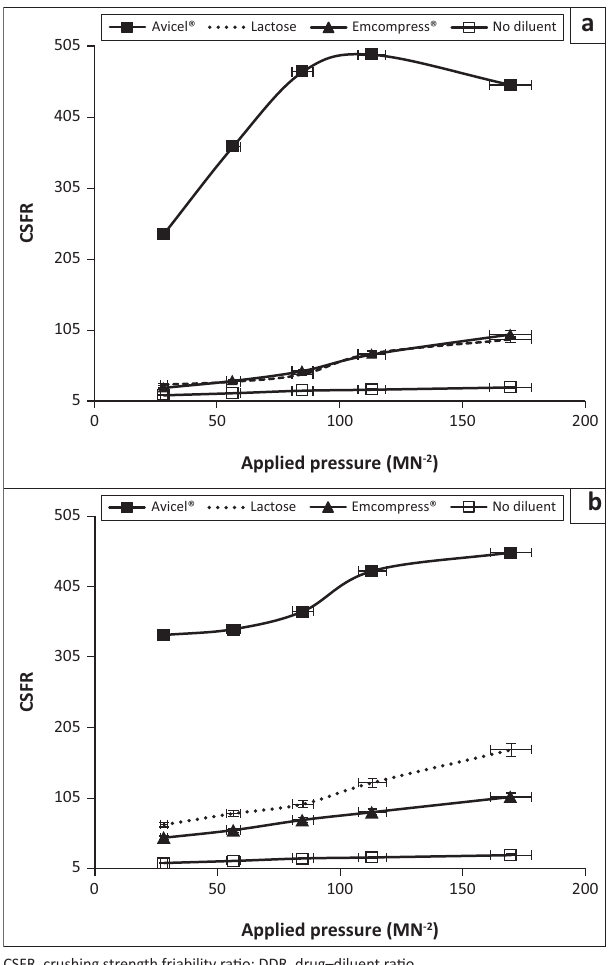
FIGURE 1: The effect of applied pressure on the crushing strength–friability ratio of Ficus exasperata herbal tablets. (a) drug–diluent ratio 1:4; (b) drug–diluent ratio 1:9.